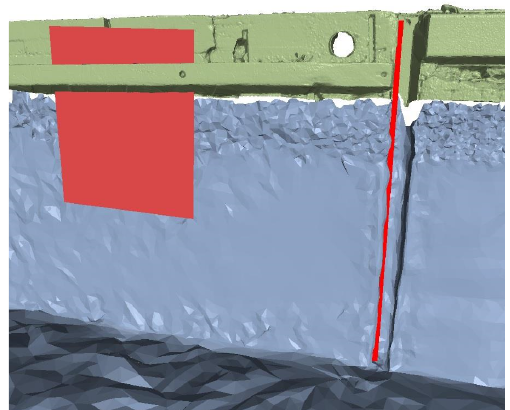
Figure 6: Geometric entities (plane, line) for attitude